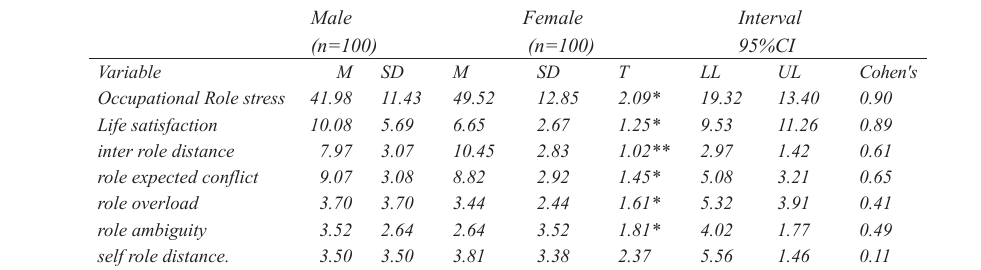
Table 4 Mean, standard deviation, and t values for male and female for study variables (N=200)